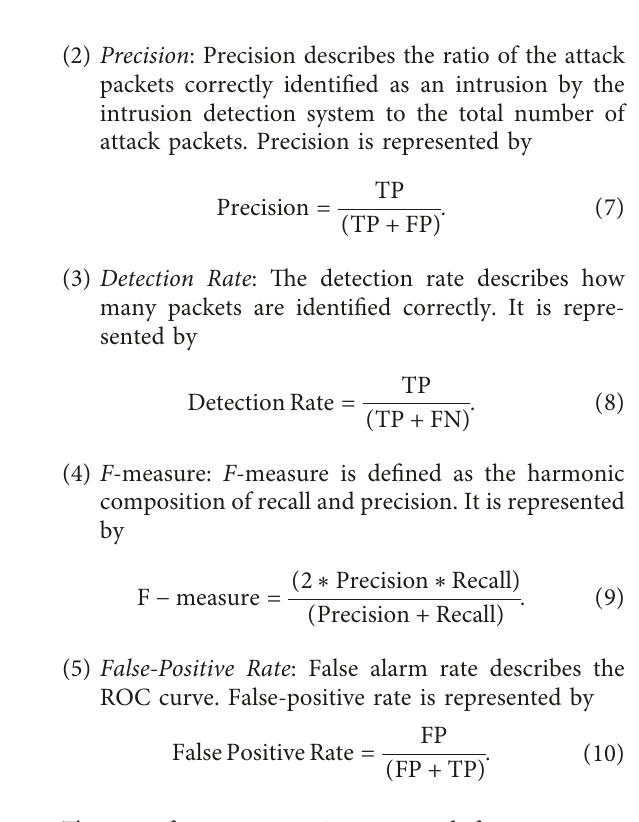
Figure 6: Flowchart of SMO-ANN